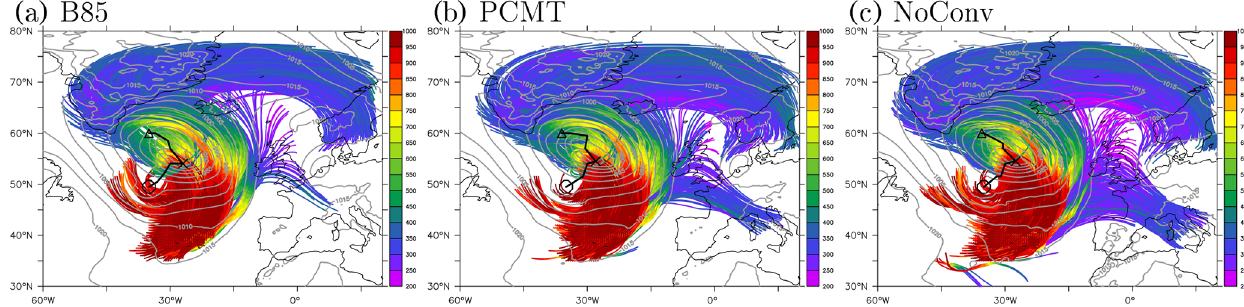
Figure 1. WCB trajectories from 12:00UTC on 1 October to 12:00UTC on 3 October coloured according to pressure (in hPa) for (a) B85, (b) PCMT and (c) NoConv simulations. The sea level pressure at 12:00UTC on 2 October is shown in grey contours (interval: 5hPa). Only WCB trajectories with an ascent criterion of at least 600hPa in 48h are shown for clarity purposes. In each panel, the black thick line represents the track of the minimum sea level pressure of the corresponding run between 12:00UTC on 1 October and 12:00UTC on 3 October. The circle, cross and triangle correspond to the position of the minimum sea level pressure at 12:00UTC on 1 October, 12:00UTC on 2 October and 12:00UTC on 3 October respectively.